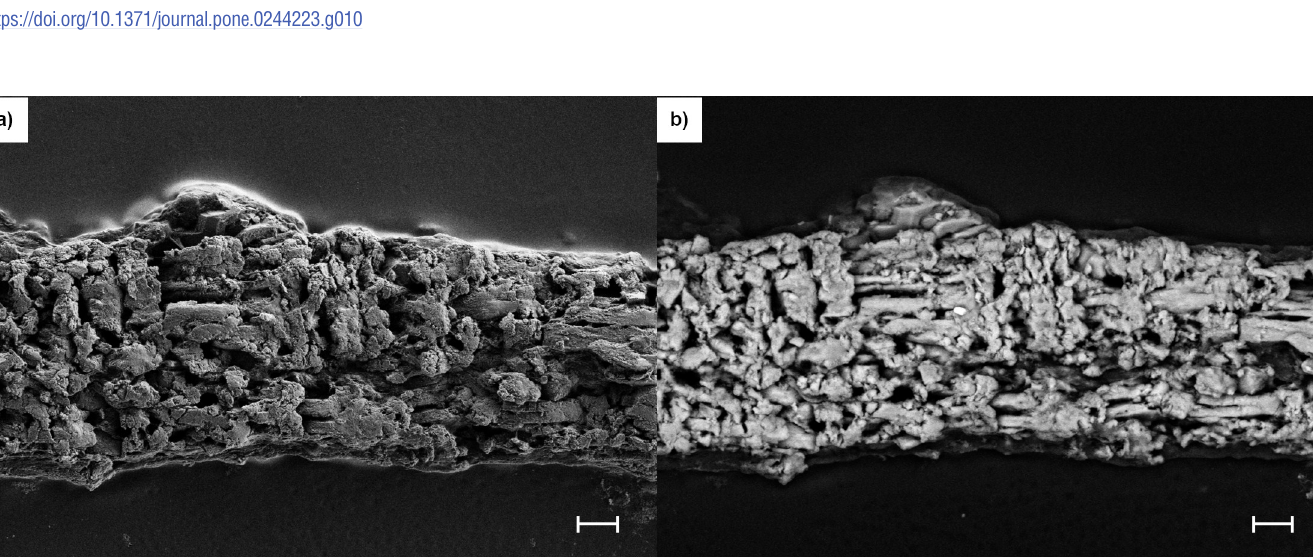
PLOS ONE | https://doi.org/10.1371/journal.pone.0244223 February 4, 2021 15 /